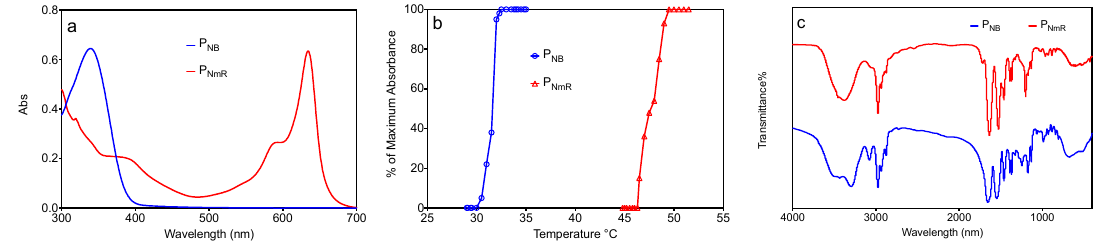
Table 1. GPC results of fluorescent polymers.